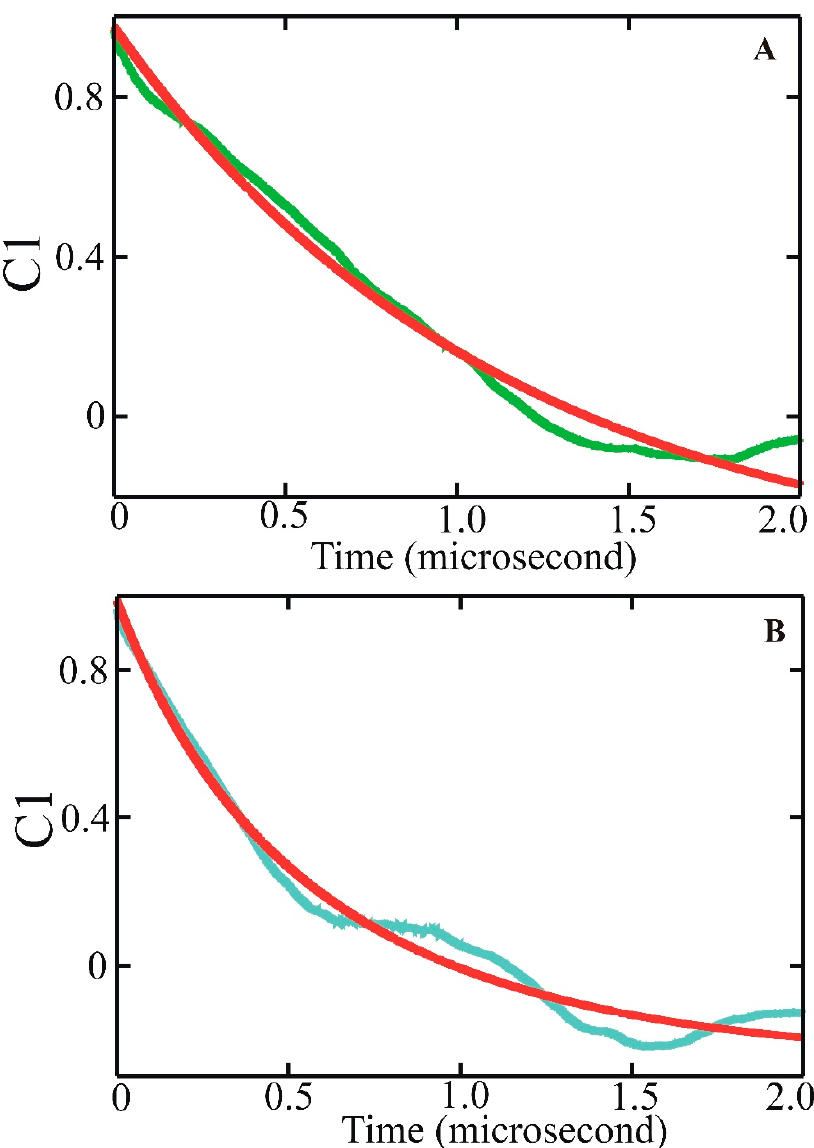
Figure 4. The average autocorrelation functions (ACFs) for length fluctuations of the 19 helical hydrogen bonds (C==Oi · · · H–Ni+4). ( A ) For WH21 0 : average autocorrelation in green with bi-exponential fit in red. ( B ) For WH21+: average autocorrelation in cyan with bi-exponential fit in red [82].